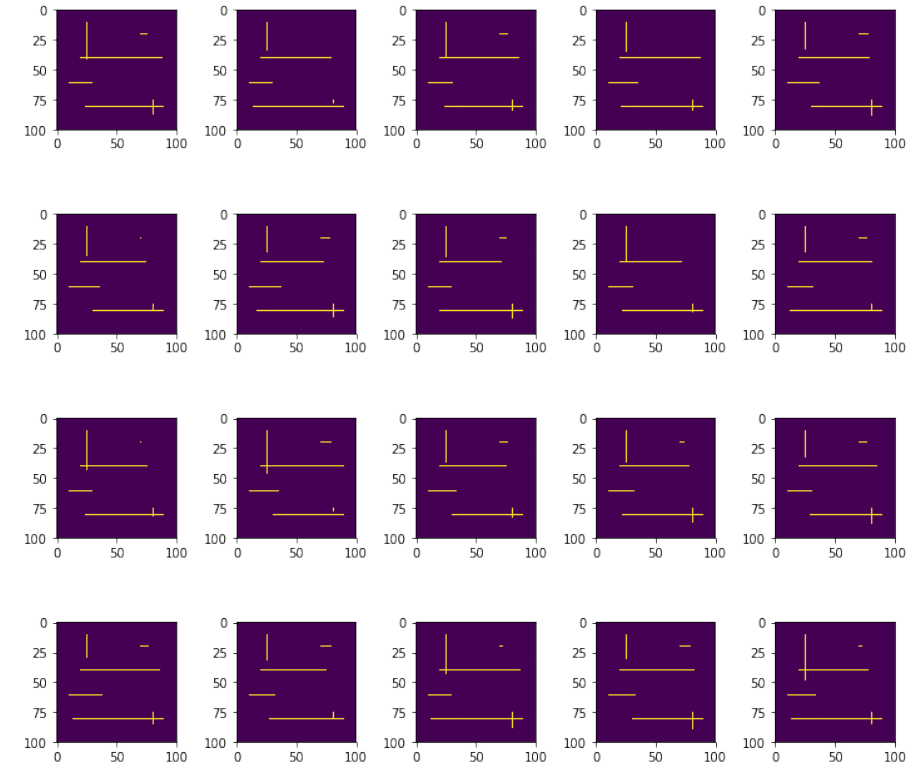
Figure 7. Heterogeneous fields, the yellow strips are the